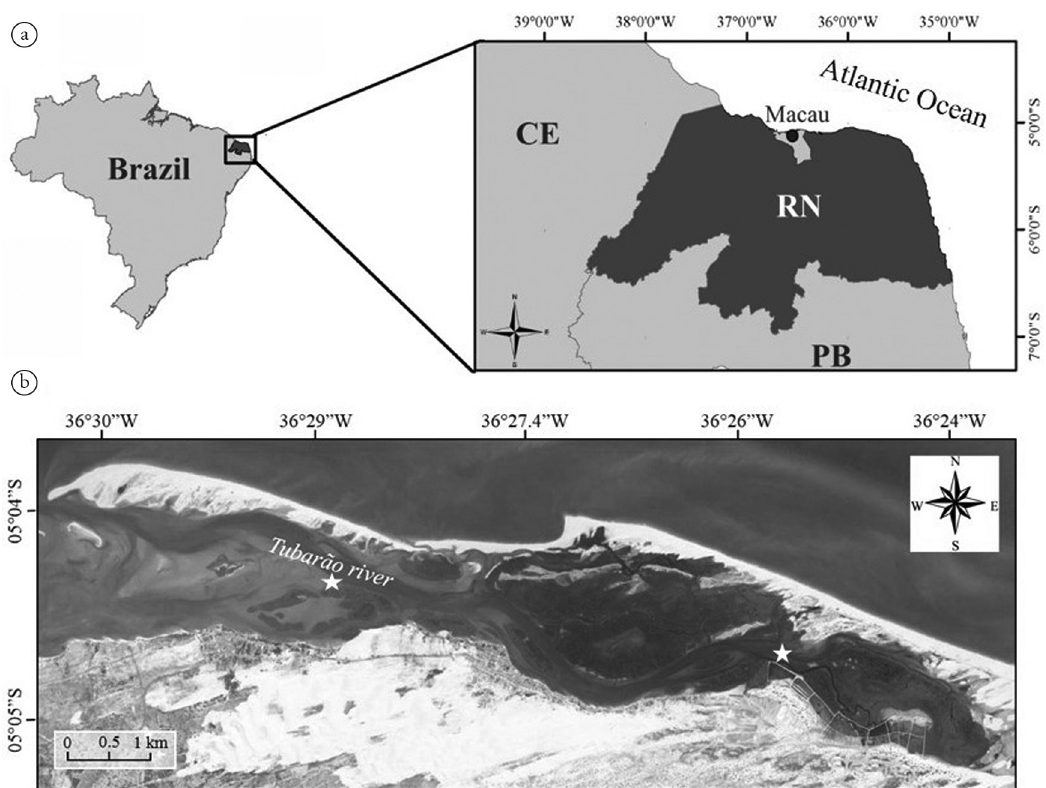
Figure 1. (a) Location of the study area in the State of Rio Grande do Norte, Northeastern Brazil; (b) Partial view of the Tubarão River. Legend:  indicates the sampling